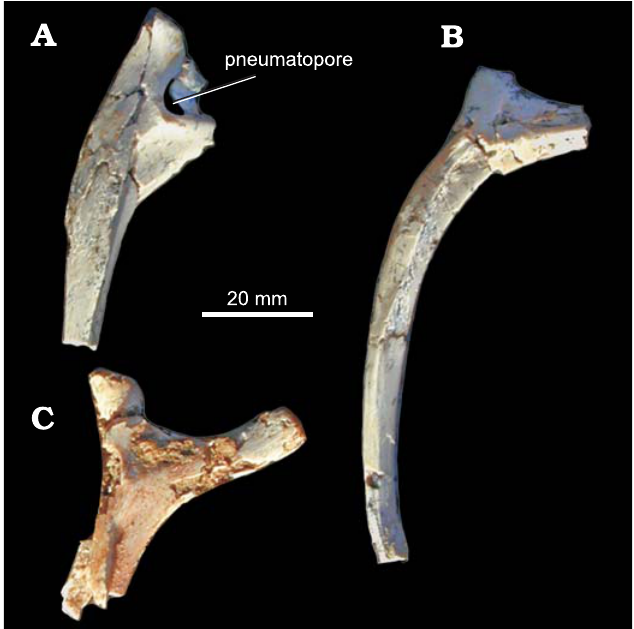
Fig. 3. Crested theropod dinosaur Elmisaurus rarus Osmólska, 1981, MPC-D 102/007 from Nemegt Formation (Upper Cretaceous), Western Sayr of Nemegt locality, Mongolia. A . ?First dorsal rib. B . Posterior dorsal rib. C . Anterior dorsal rib.